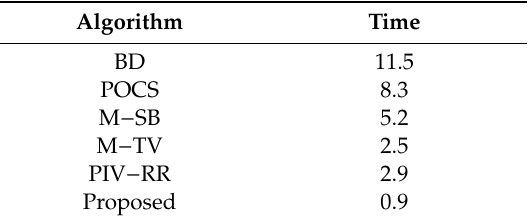
Table 2. Comparison of algorithm running time